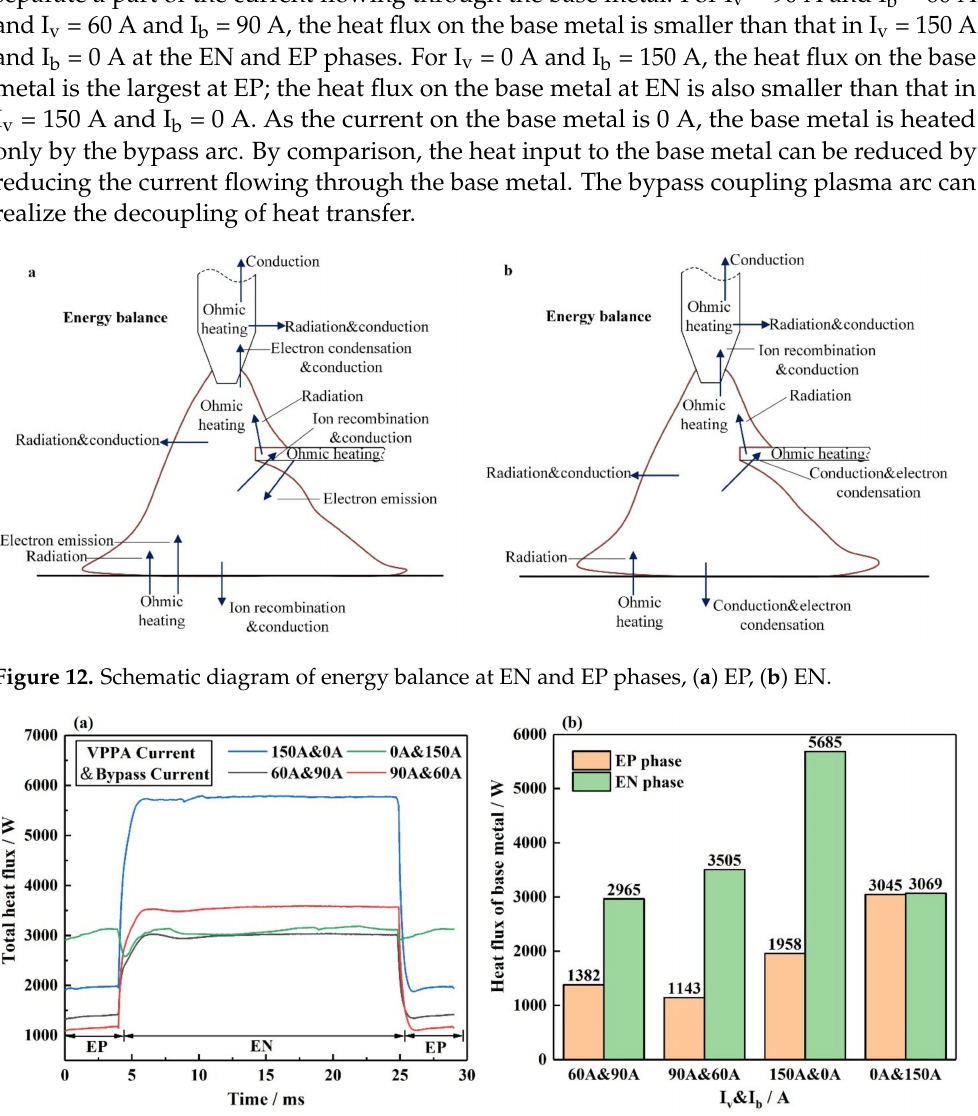
Figure 13. The total heat flux on the interface between bypass coupling plasma arc and base metal under different current conditions, ( a ) energy distribution over the period, ( b ) specific values of